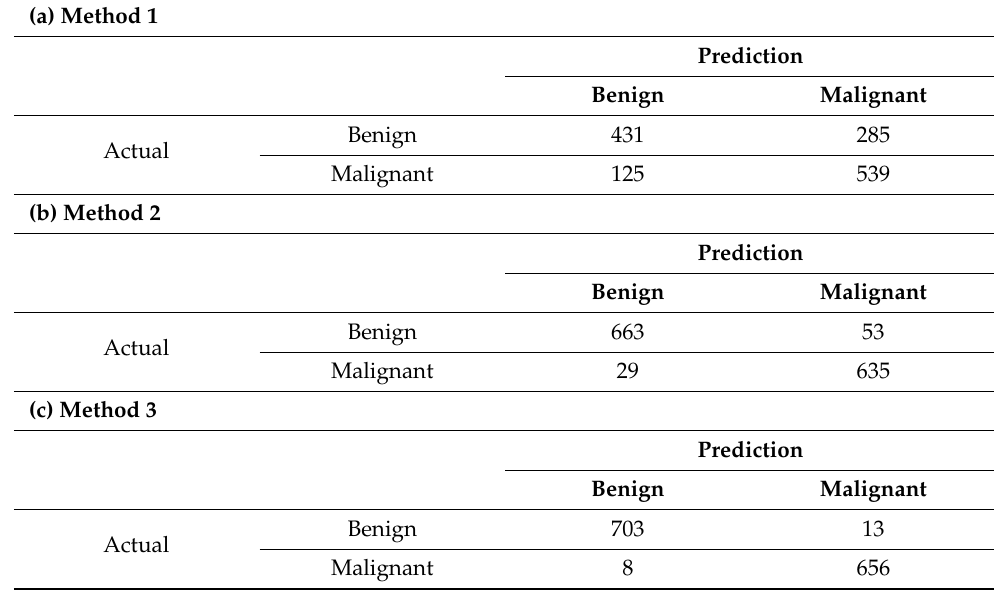
Figure 3. Correctly classified and misclassified images and their activation maps. Benign cells correctly classified ( A – C ) and misclassified ( D – F ) images in Methods 1–3, respectively. Same for the Malignant cells: correctly classified ( G – I ) and misclassified ( J – L ) images. Papanicolaou staining (left panel) and activation map by Grad-CAM (right panel) in each photo. Table 1. Confusion matrices of the three classification methods.